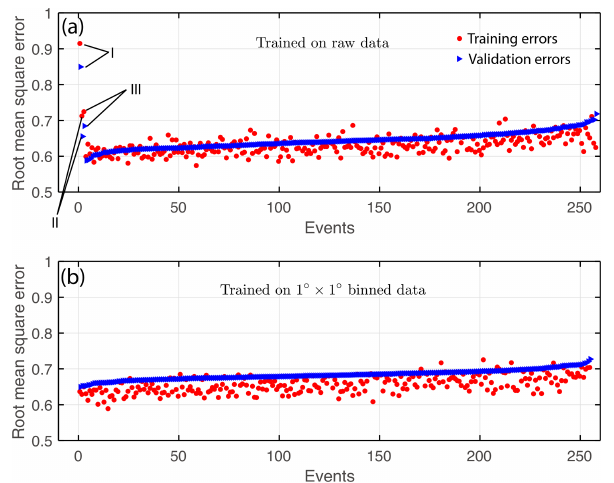
Figure 2. Parameter sensitivity tests on raw and binned data. (a) Root mean square error on a logarithmic scale for the model trained using raw data; (b) root mean square error on a logarith- mic scale for the model trained using binned data . The time and location parameters are tested separately without combining with environmental parameters as shown in the upper panel, (I) with only location parameters; (II) with location and day-of-year param- eters; and (III) with location, day-of-year, and time-of-day parame- ters. The model with three location parameters (I) has a root mean square error on a natural logarithmic scale of ∼ 0 . 83, which de- creases to ∼ 0 . 65 by adding sampling day-of-year parameters (II) but increases to ∼ 0 . 67 by adding time-of-day parameters (III). We, therefore, do not include time-of-day parameters in the following tests. We tested every combination of the eight parameters (PAR, MLD, SST, SSS, Chl a , DIP, DIN, and SiO 4 ), which in total are 255 tests.